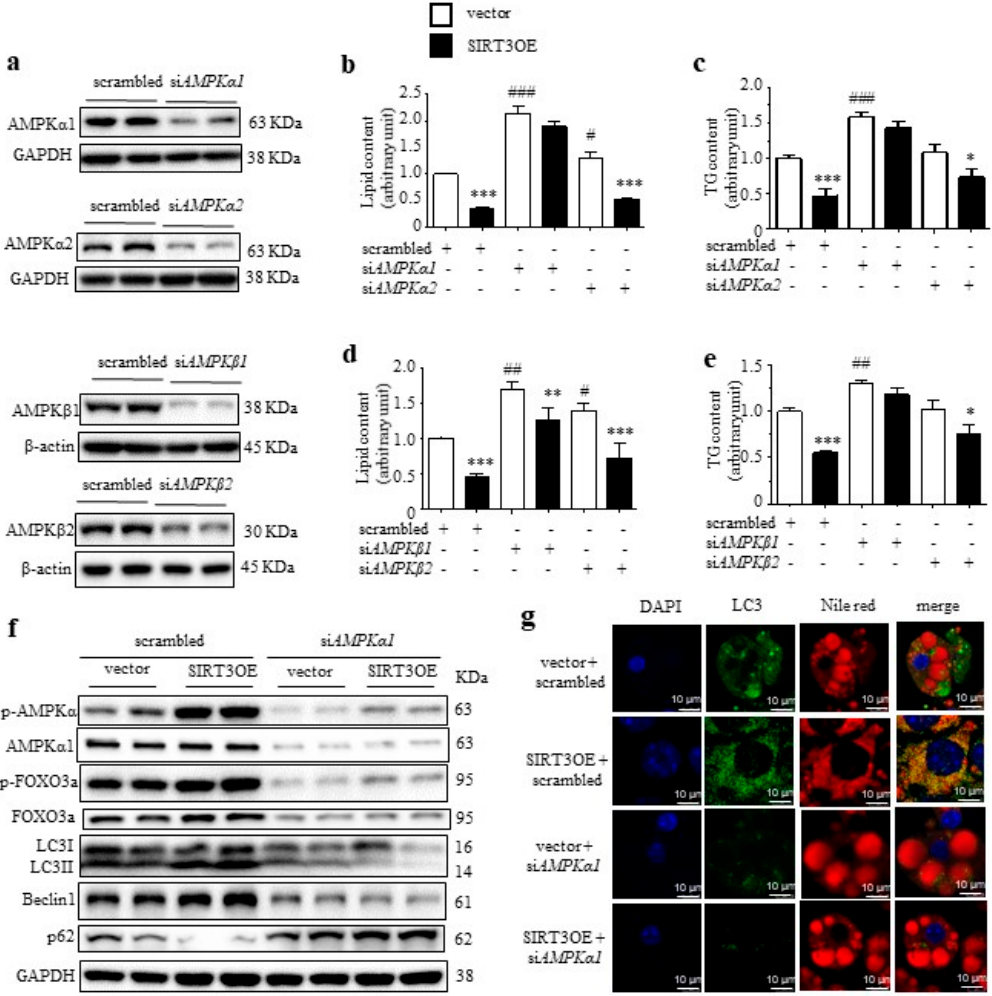
Figure 4. Knockdown of AMPK α 1 reversed SIRT3-induced activation of macroautophagy. ( a ) Generation of si AMPK α 1 , si AMPK α 2 , si AMPK β 1 and si AMPK β 2 cell lines. The lipid content ( b ) and the cellular TG content ( c ) in vector and SIRT3OE adipocytes with silenced AMPK α 1 or AMPK α 2 . * p < 0.05 and *** p < 0.001 vector versus SIRT3OE cells. # p < 0.05 and ### p < 0.001 scrambled vs. si AMPK α 1 /si AMPK α 2 . The lipid content ( d ) and the cellular TG content ( e ) in vector and SIRT3OE adipocytes with silenced AMPK β 1 or AMPK β 2 . * p < 0.05, ** p < 0.01, and *** p < 0.001 vector versus SIRT3OE cells. # p < 0.05 and ## p < 0.01 scrambled vs. si AMPK β 1 /si AMPK β 2 . ( f ) LC3, Beclin1, p62, phosphorylated AMPK, total AMPK, phosphorylated FOXO3a and total FOXO3a protein levels in vector and SIRT3OE adipocytes with or without silenced AMPK α 1 . GAPDH was used as a loading control. ( g ) Immunofluorescence of LC3 (green) and fluorescence of Nile Red (red) in SIRT3OE and vector cells with or without silenced AMPK α 1 . Nuclei were stained with DAPI (blue). Scale bar = 10 μ m. Data represented means ± S.D., n = 6.